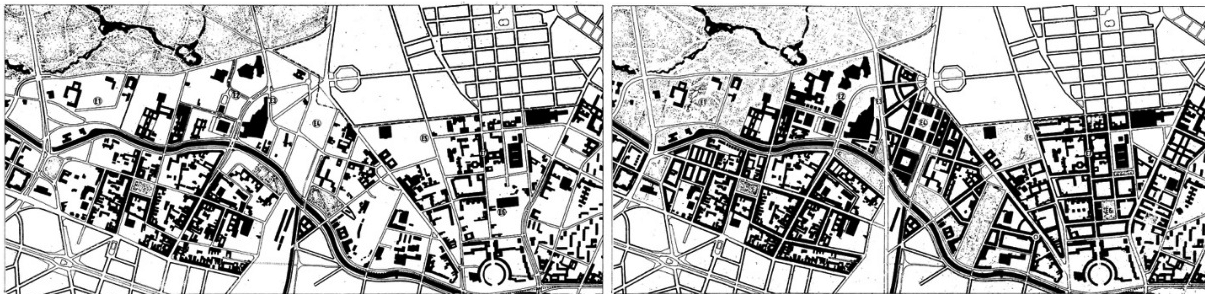
Figure 15. IBA Berlin: Solid-void plan, actual state at the time and proposed design. Source: Kleihues (1981). Urban Planning, 2019, Volume 4, Issue 3, Pages